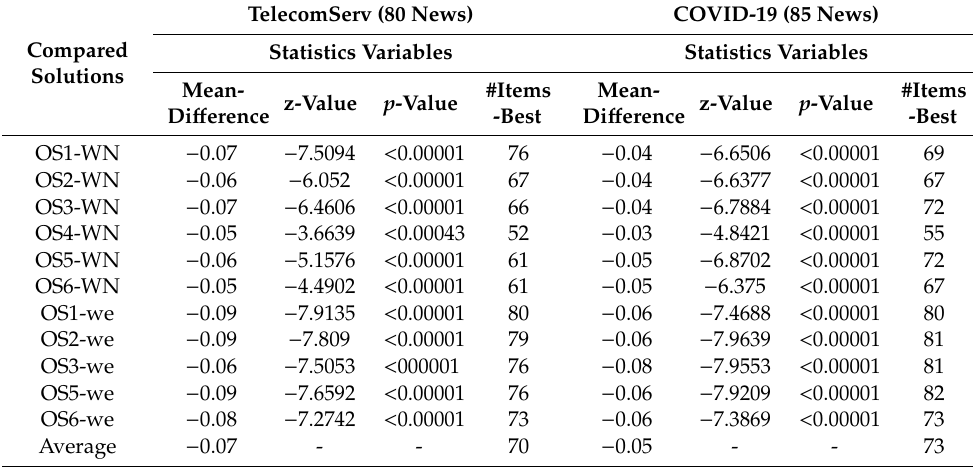
Table 5. Statistical results of Wilcoxon’s test from OS4-we vs evaluated